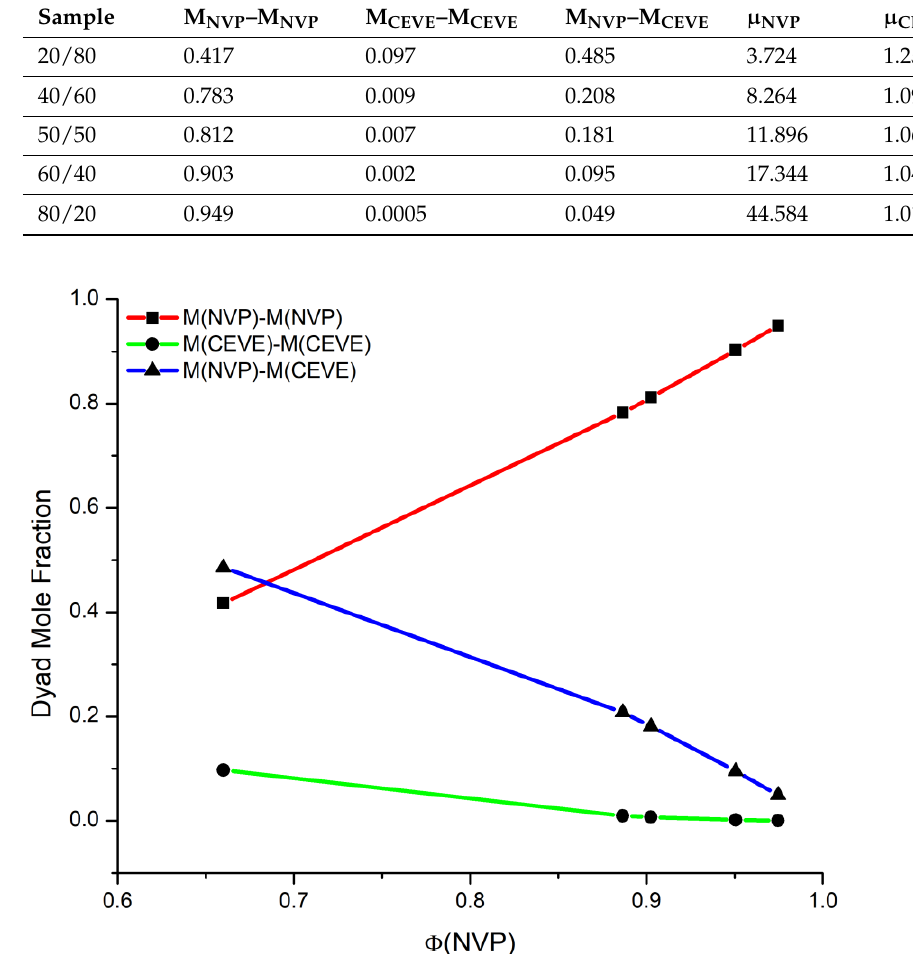
Figure 3. Dyad sequence distribution of the P(NVP-stat-CEVE) copolymers.